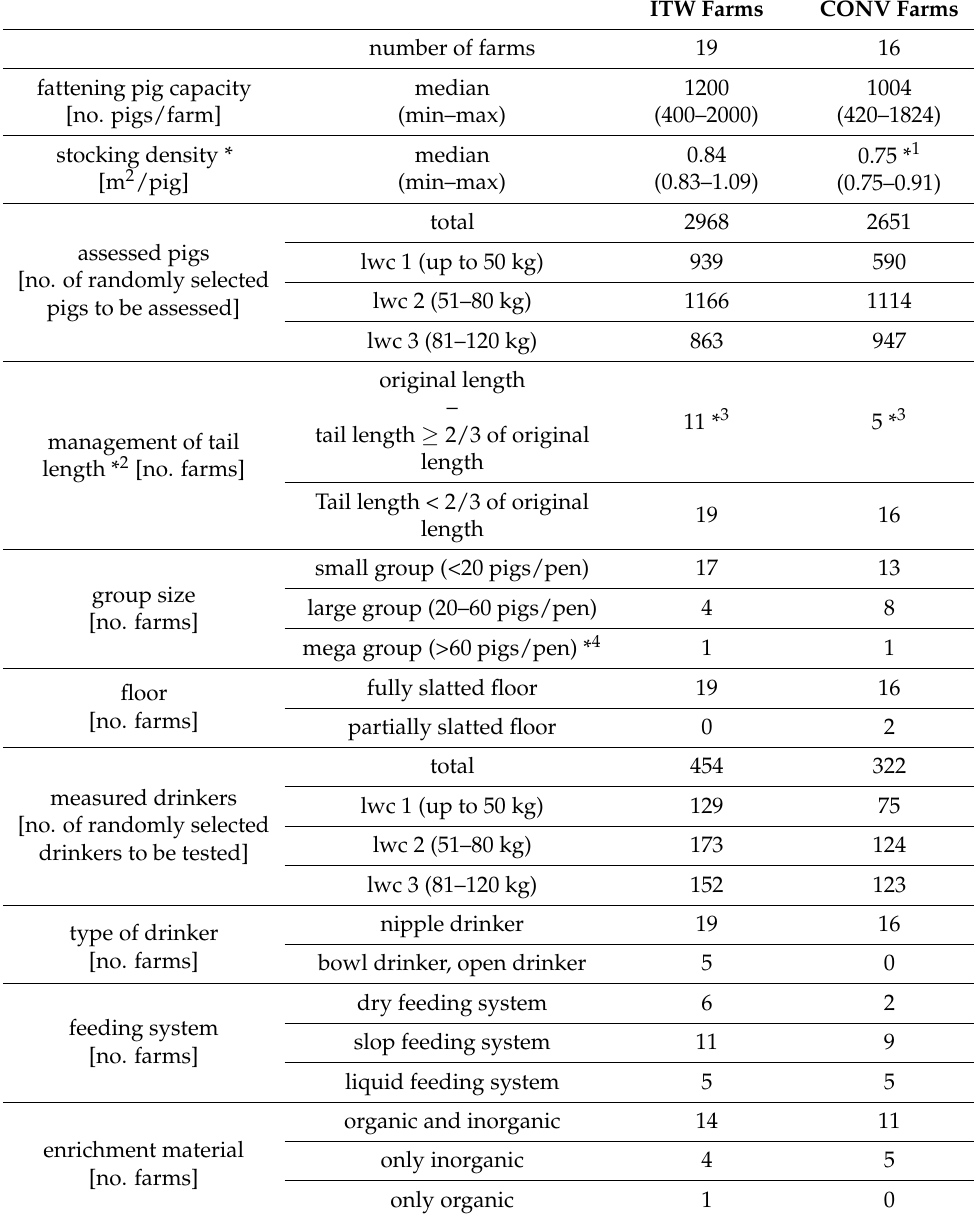
Table 4. Description of housing conditions on ITW and CONV